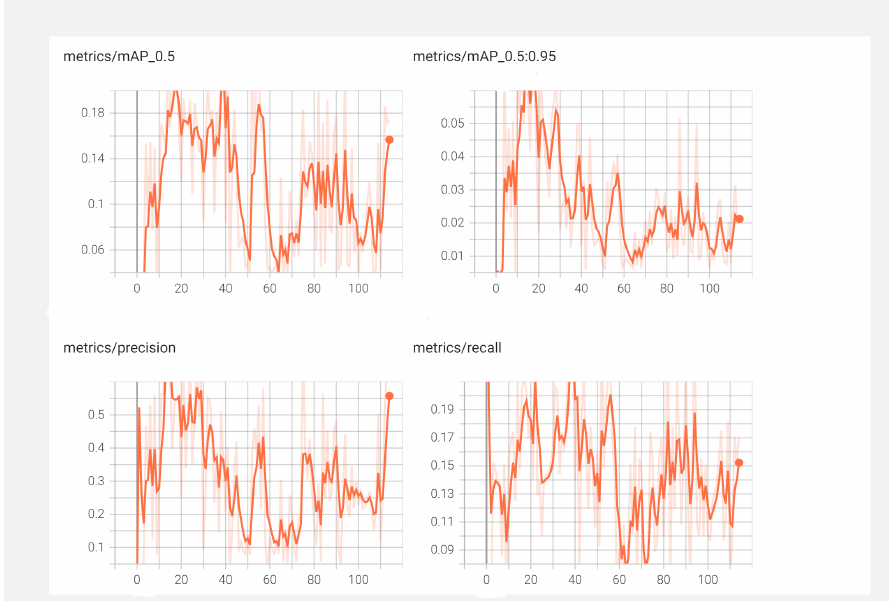
Figure 21. mAP Graphs mAP, precision, recall, is increasing or decreasing with changes in hyperpa- rameters.